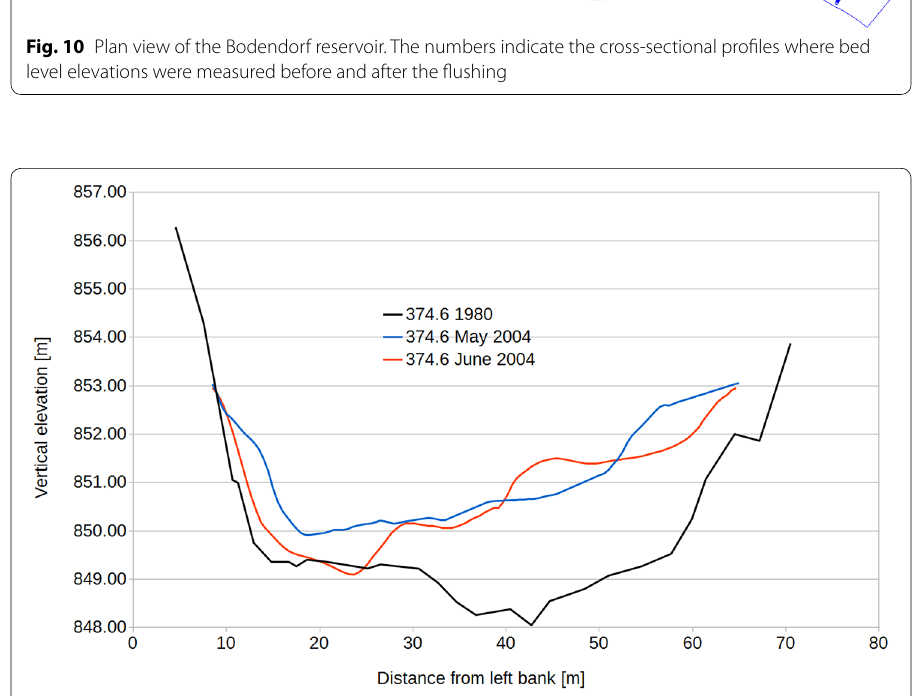
Fig. 11 Cross-section 374.6 with measured bed elevations before and after the reservoir flushing in